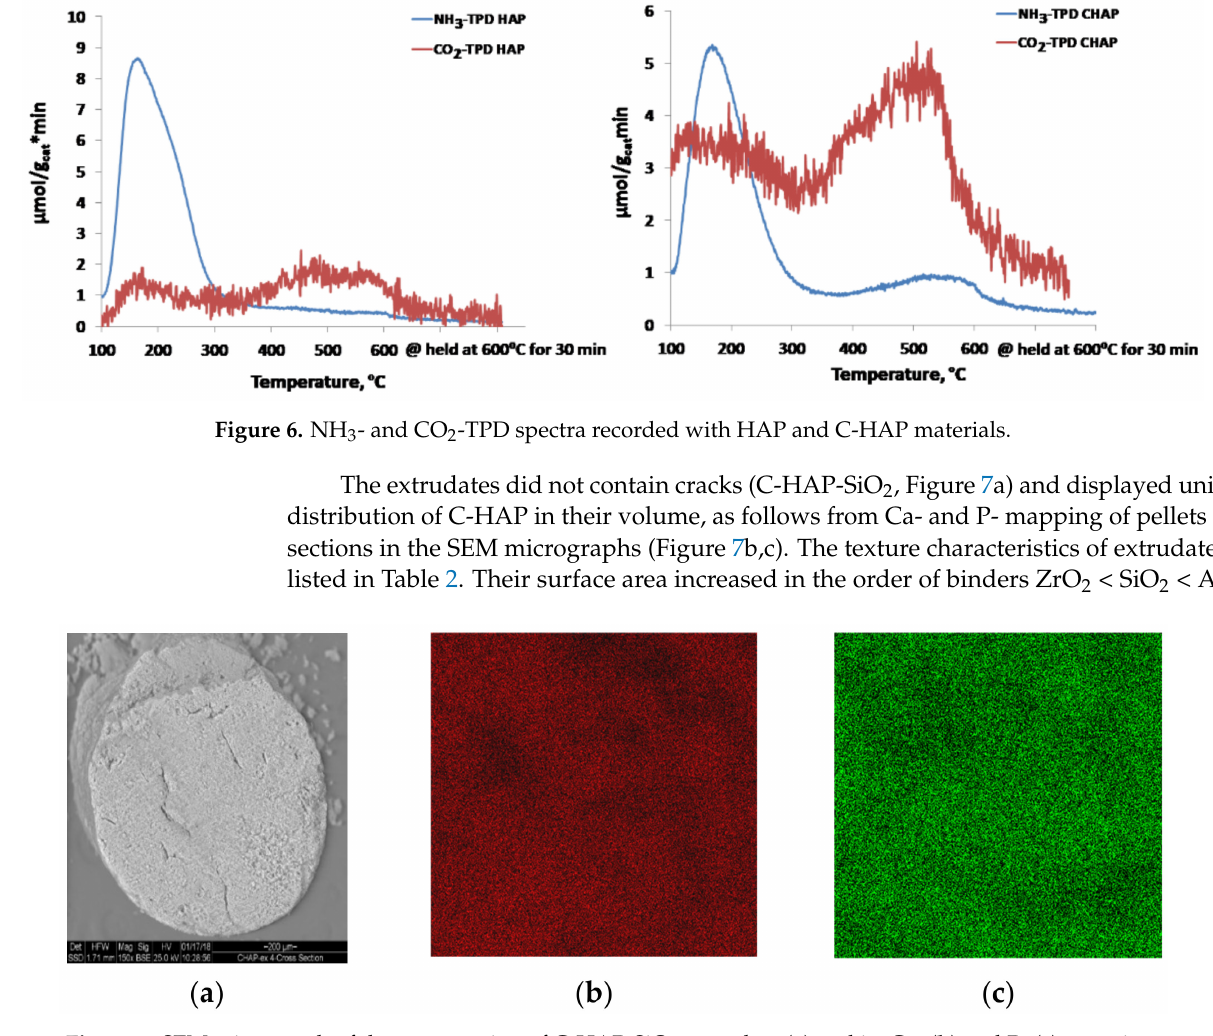
Figure 7. SEM micrograph of the cross section of C-HAP-SiO 2 extrudate ( a ) and its Ca- ( b ) and P- ( c )